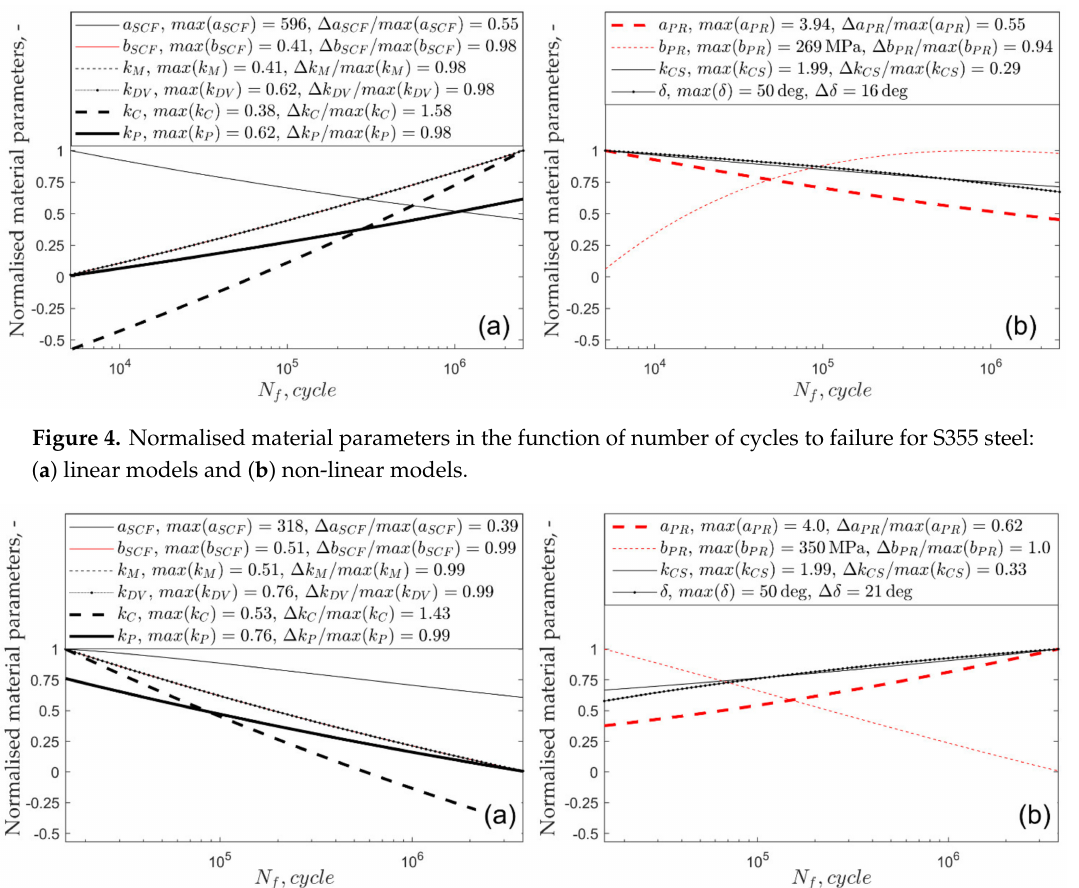
Figure 5. Normalised material parameters in the function of number of cycles to failure for aluminium alloy 7075-T651: ( a ) linear models and ( b ) non-linear models.